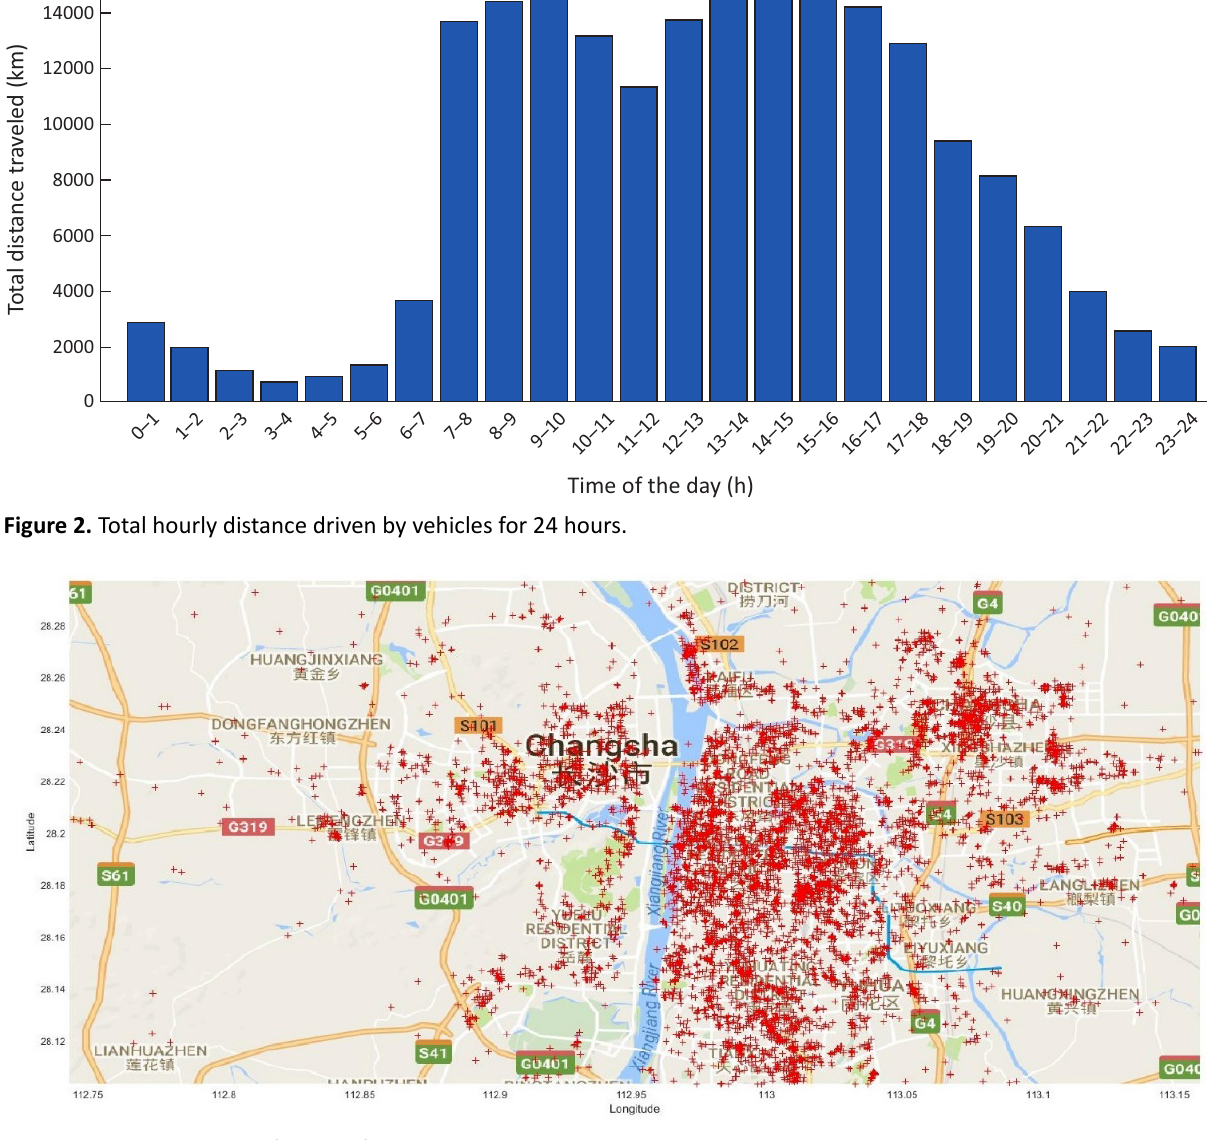
Figure 3. Trips start points (red dots) for 24 hours. Table 1. Simulation set up parameters (study